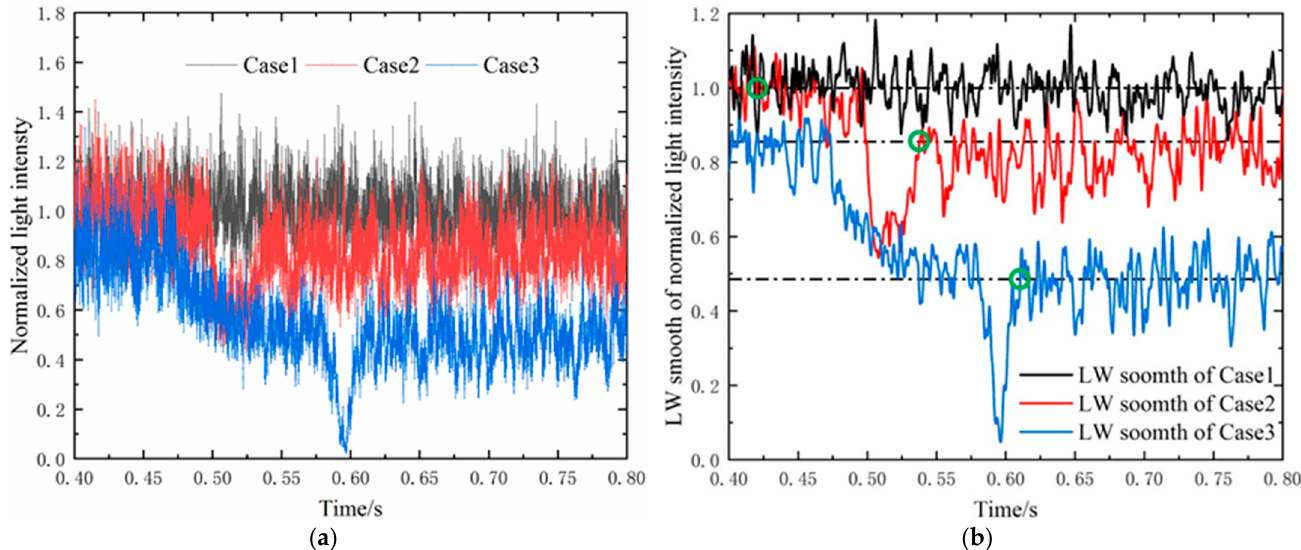
Figure 12. Light intensity profiles in the combustor with injection pressure drops of 0.23, 0.43, and 0.92 MPa. ( a ) Normalized light intensity. ( b ) Locally weighted smoothing of the normalized light intensity.